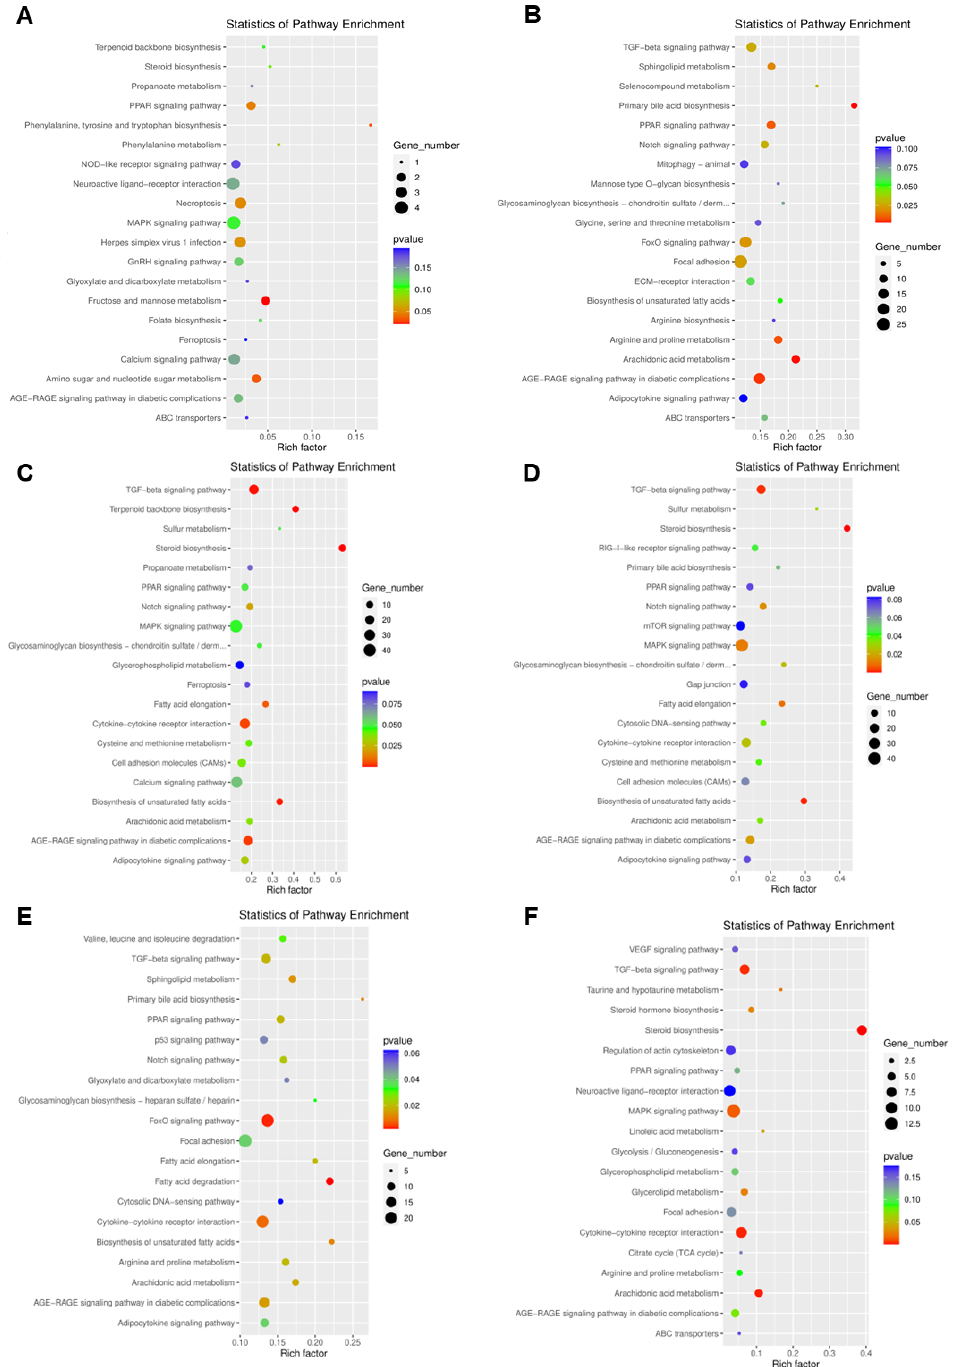
Figure 5. KEGG enrichment analysis of transcriptional differential genes in each comparison group. ( A ) is the comparison group of SP and Control. ( B ) is the comparison group of BBR and Control. ( C ) is the comparison group of SP + BBR and Control. ( D ) is the comparison group of SP + BBR and SP. ( E ) is the comparison group of BBR and SP. ( F ) is the comparison group of SP + BBR and BBR comparison